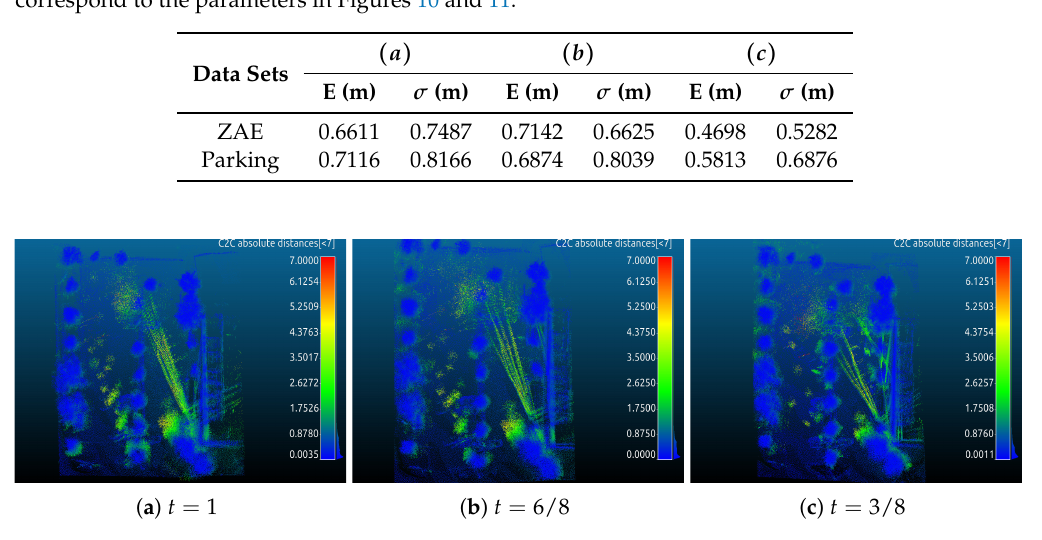
Figure 10. The visual inspection of computed errors from the ZAE data set: ( a ) indicates the result of pure HectorSLAM + continuous-time SLAM and ( b , c ) are from our curvefusion + continuous-time SLAM. Compared to Figure 7, only the three best results are given. Table 1. The proposed method for ground truth error and its standard deviation error. ( a ) , ( b ) , ( c ) correspond to the parameters in Figures 10 and 11.